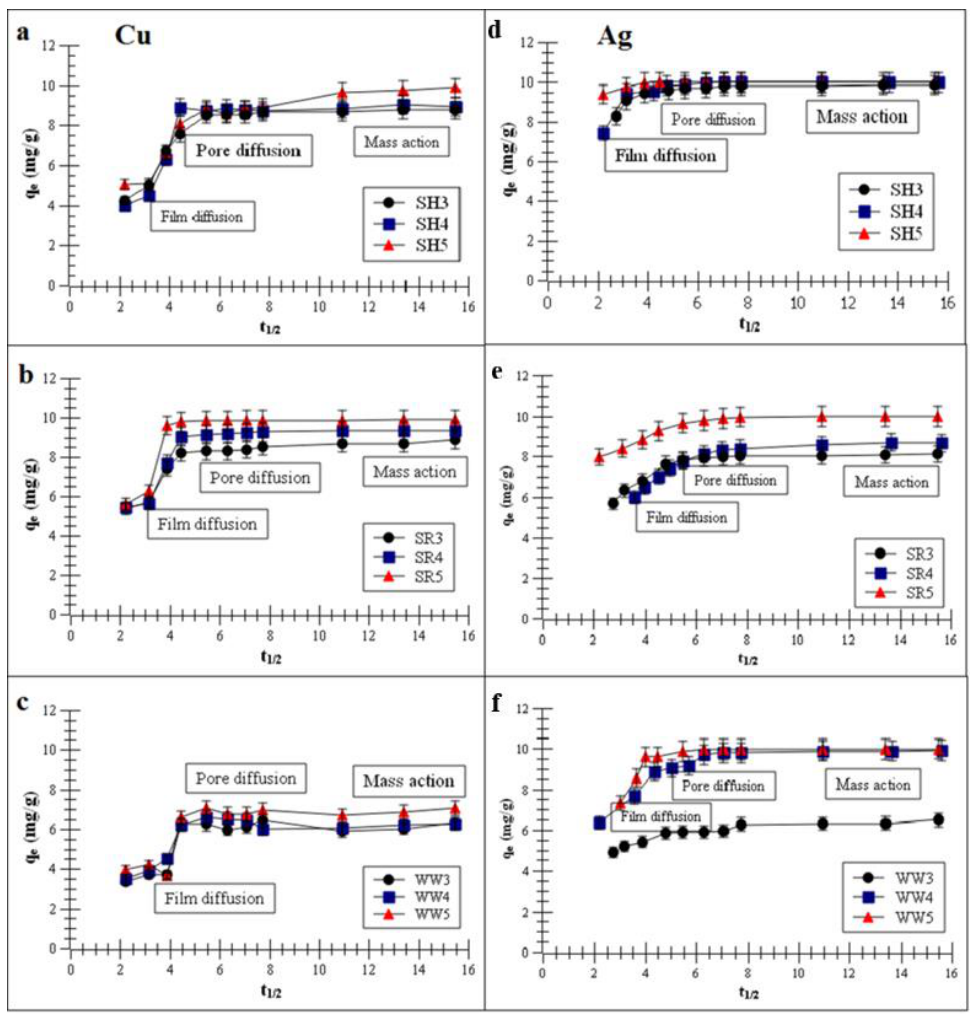
Figure 3. Intra-particle diffusion (IPD) model of the metal adsorptions on the biochars ( a , d ) biochar derived from sunflower husks; ( b , e ) biochar derived from sunflower husks and rapeseed pomace; ( c , f ) biochar derived from wood waste): SH3 (sunflower husks, 300 °C), SH4 (sunflower husks, 400 °C), SH5 (sunflower husks, 500 °C), SR3 (sunflower husks + rapeseed pomace, 300 °C), SR4 (sunflower husks + rapeseed pomace, 400 °C), SR5 (sunflower husks + rapeseed pomace, 500 °C), WW3 (wood waste, 300 °C), WW4 (wood waste, 400 °C) and WW5 (wood waste, 500 °C); q e is the heavy metal removal capacity at equilibrium and t 1/2 is half-adsorption time.